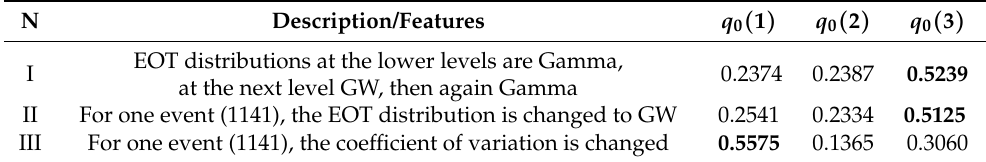
Table 2. Estimated probabilities for the system.